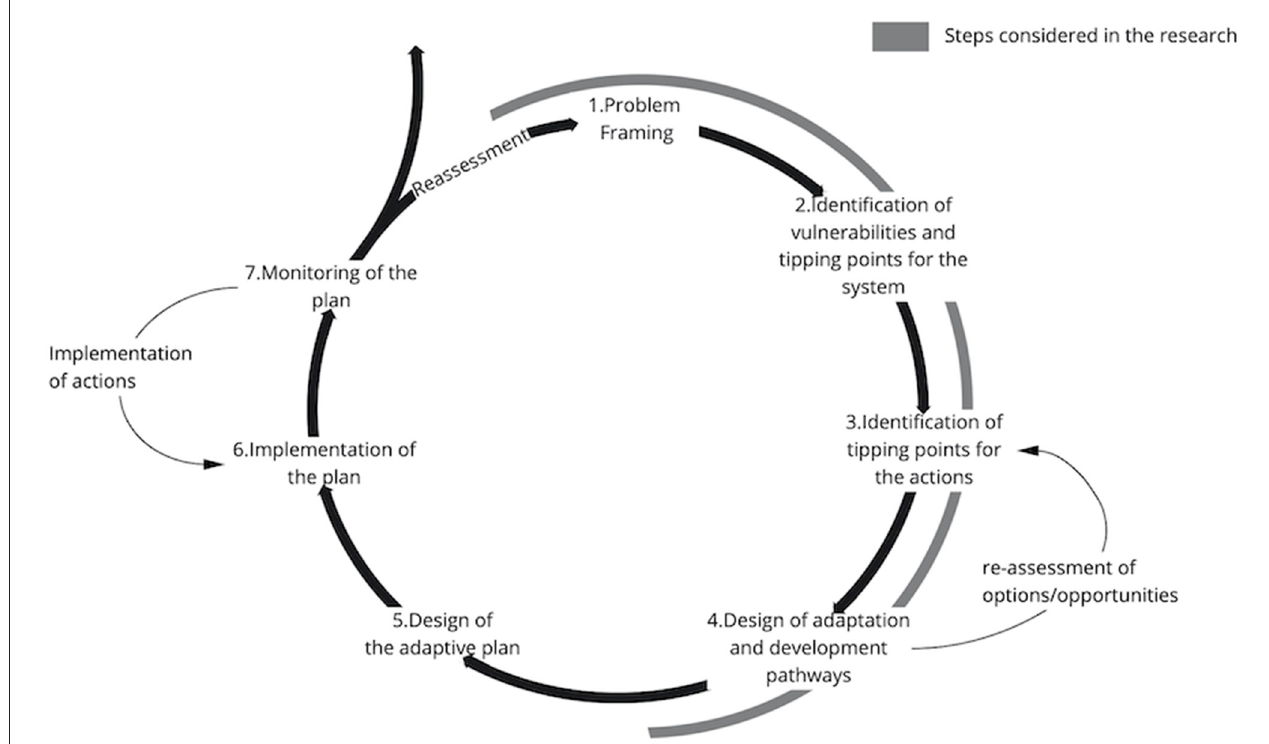
FIGURE 1 | DAPP framework (adapted from Haasnoot et al., 2019).